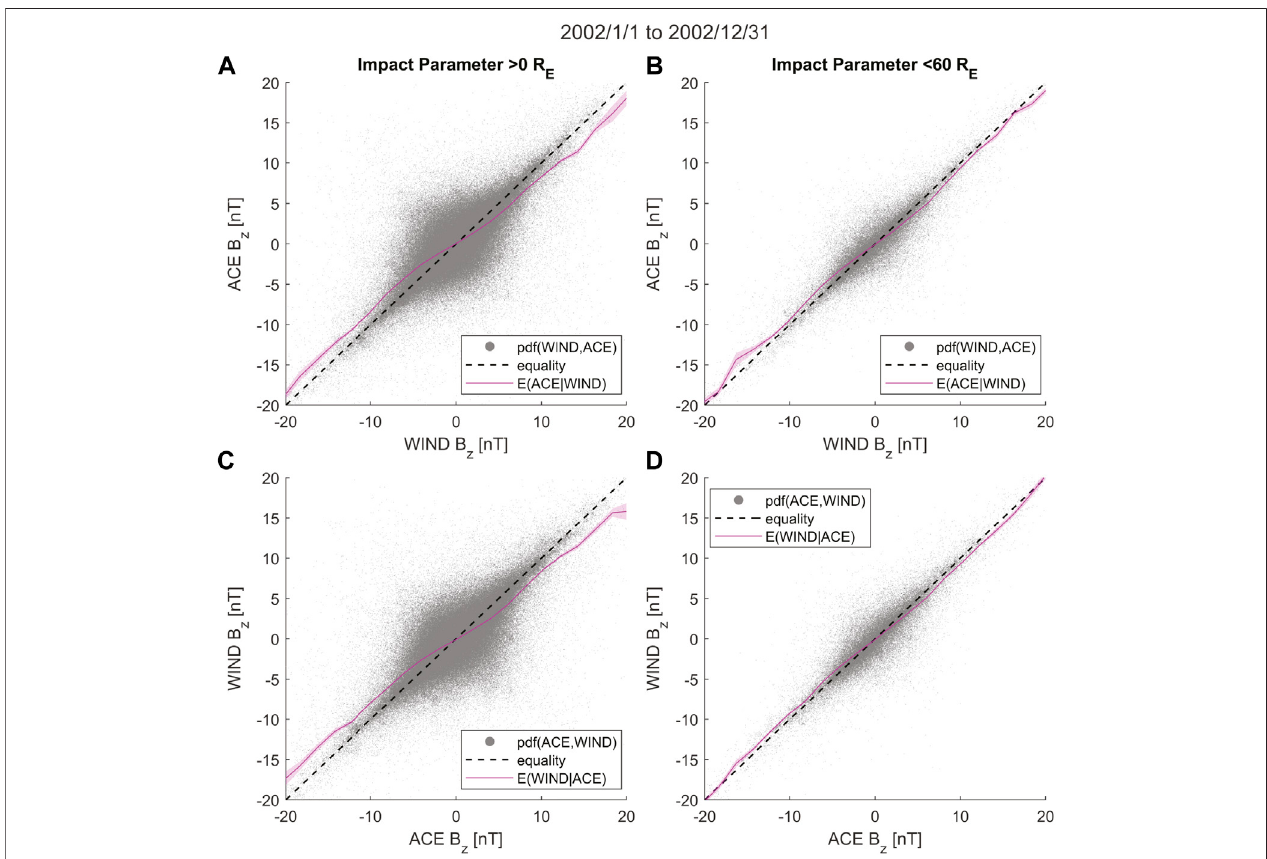
FIGURE 8 | Regression bias in solar wind magnetic fi eld Z-GSM component. The bias reduces when fi ltering the data used by reducing the impact parameter (IP) between ACE and WIND. (A) Shows a scatter plot of simultaneous 1-min resolution propagation delay-corrected ACE B z vs. WIND B z . The measurements used were fromtheyear2002.Thedashedblacklineisthelineofequality,andthemagentalineistheconditionalexpectation E ( B ACE z | B WIND z ) ortheregressionfunctionshowingthe regressionbias. (B) Thesameplotas (A) showingconsiderablylessregressionbiasbyrestrictingthemeasurementstotimeinstanceswhenIP < 60 R E (C) Sameas (A) but reversing the regression function to plot E ( B WIND z | B ACE z ) . (D) Same plot as (C) showing less regression bias by restricting the measurements to time instances when IP between ACE and WIND is less than 60 R E